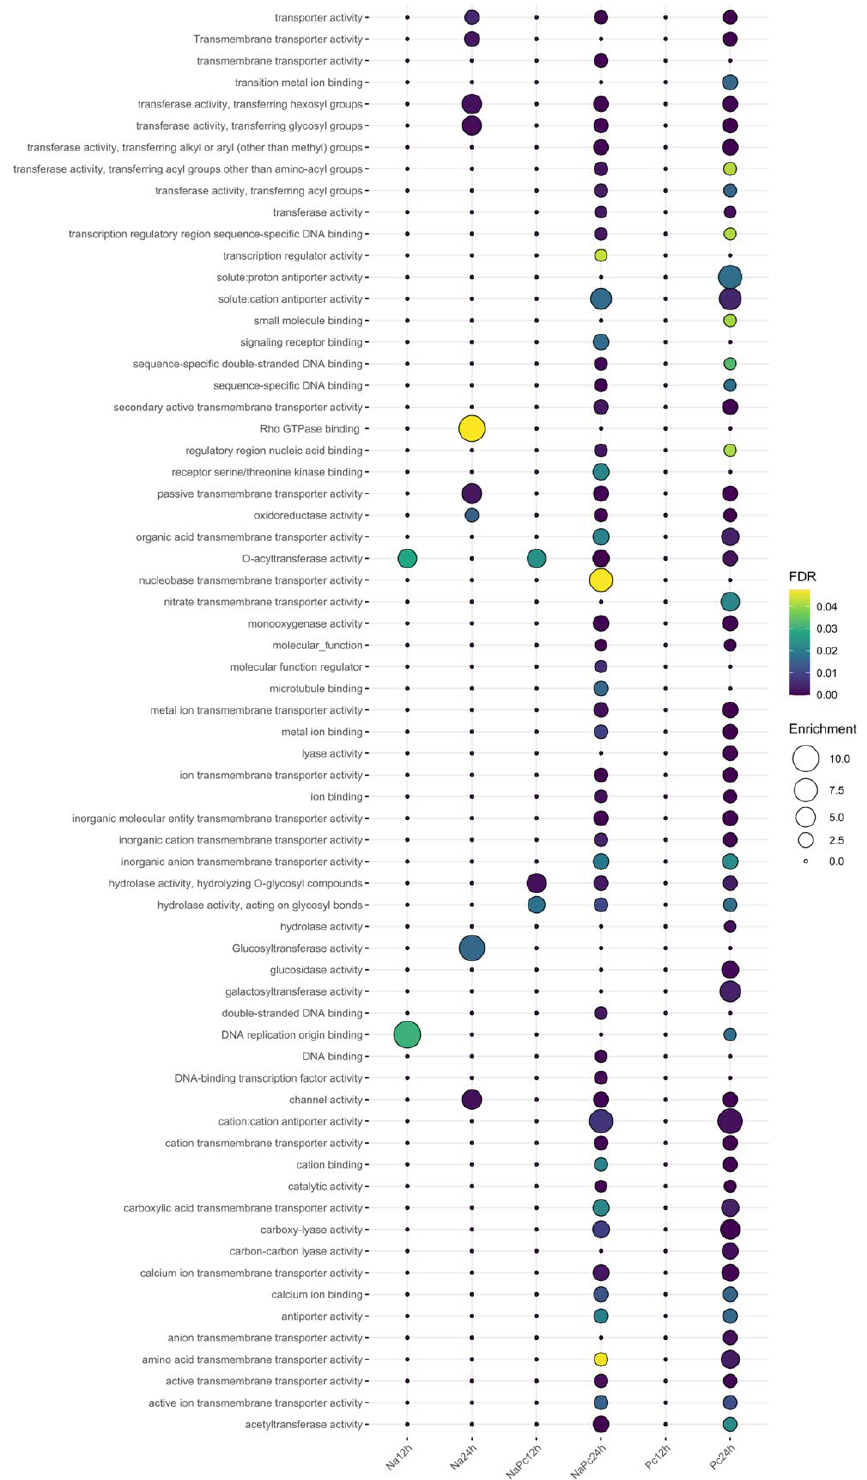
Figure 6. GO enrichment analysis from top 25 downregulated genes. FDR analysis in yellow/purple gradient being darker closer to 0. Fold enrichment (bubble size) is assigned to each KEGG pathway. p < 0.05.